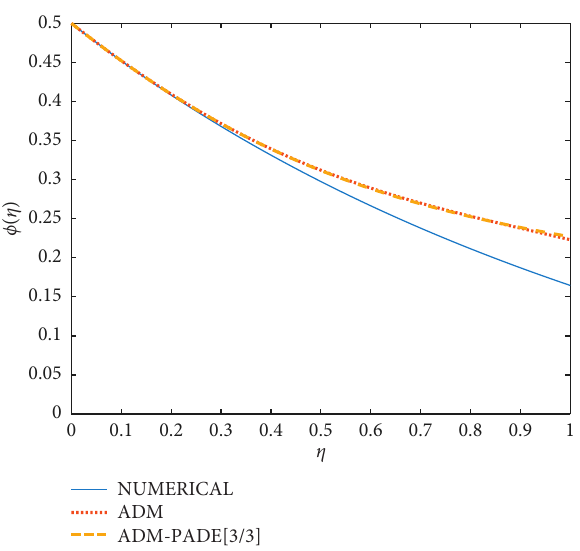
Figure 7: Comparative plot of concentration